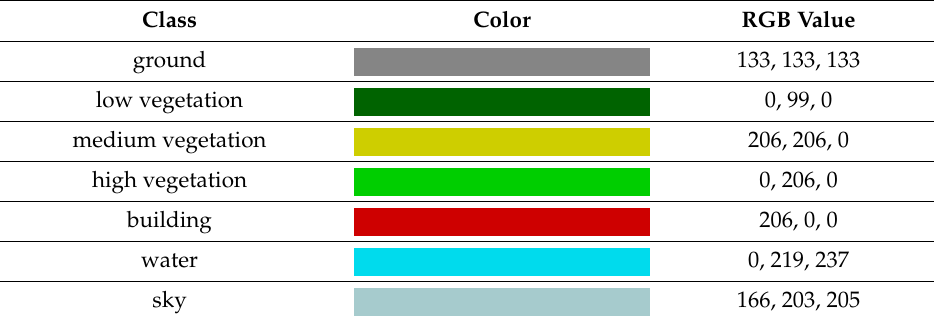
Table 2. Object classes in the 3D